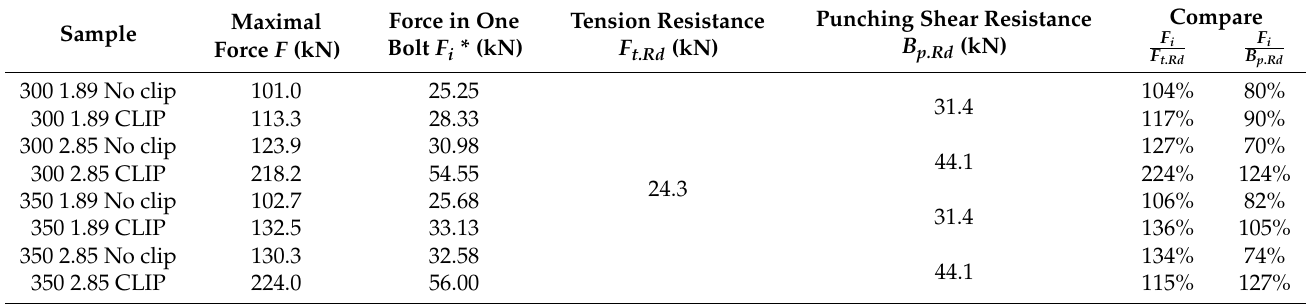
Table 3. Results from experimental tests and comparison to normative